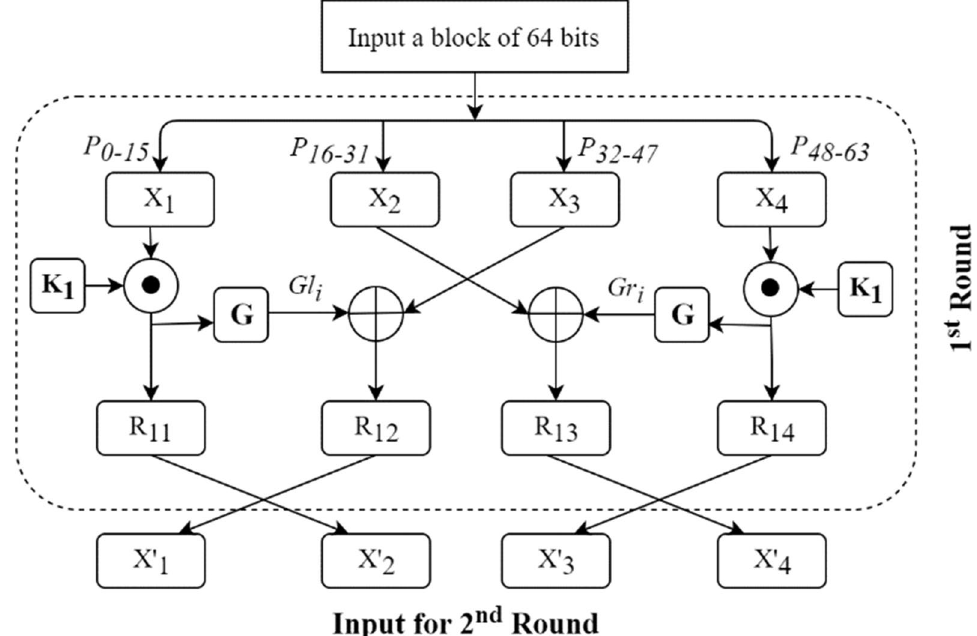
Fig. 5 The first round of encryption and input for 2nd round (RBFK-64